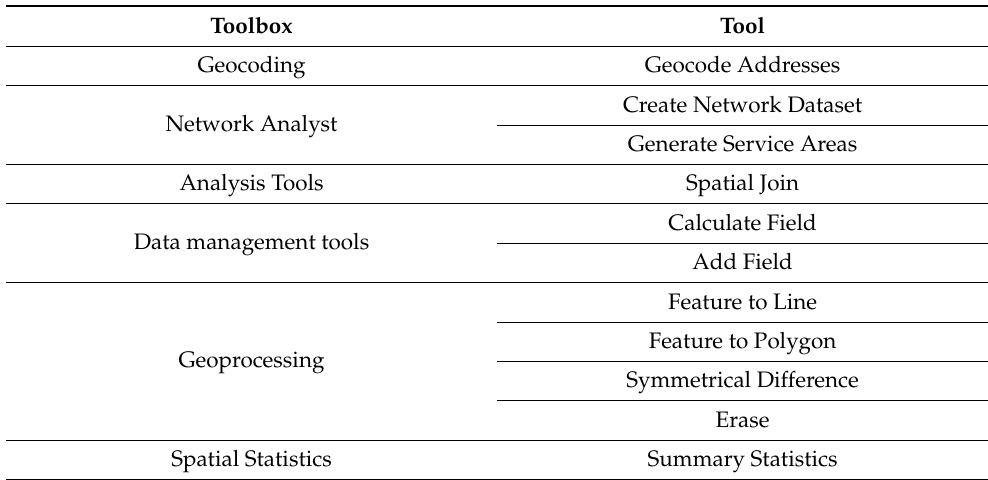
Table 6. GIS tools used during the development of the